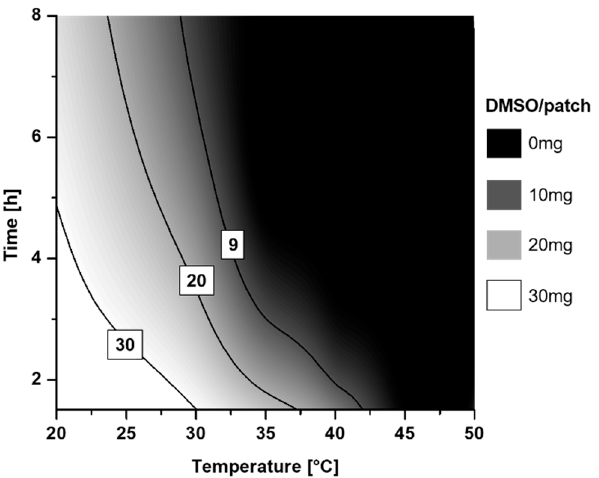
Figure 1. Contour plot of the effect of drying time and temperature on the residual amount of DMSO/patch. The line with the value 9 displays the maximum amount of DMSO (9 mg) which can be incorporated to produce a suitable transdermal patch.